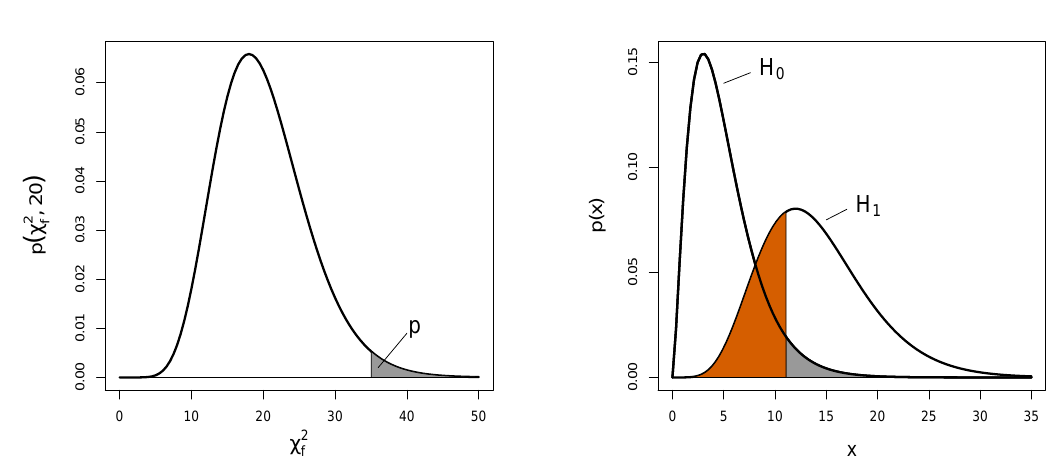
(cid:128) (cid:138) χ 2 Figure 4: In the left plot the probability density p ,20 of a χ 2 –random variable f with 20 degrees of freedom is shown. The shaded area marks the probability p = 0.02 > 35.0. The right plot shows the probability densities of of obtaining a value of χ 2 f the null hypothesis and the alternative hypothesis. In this situation we have a false positive rate α = 0.05 (grey) and a false negative rate β = 0.32